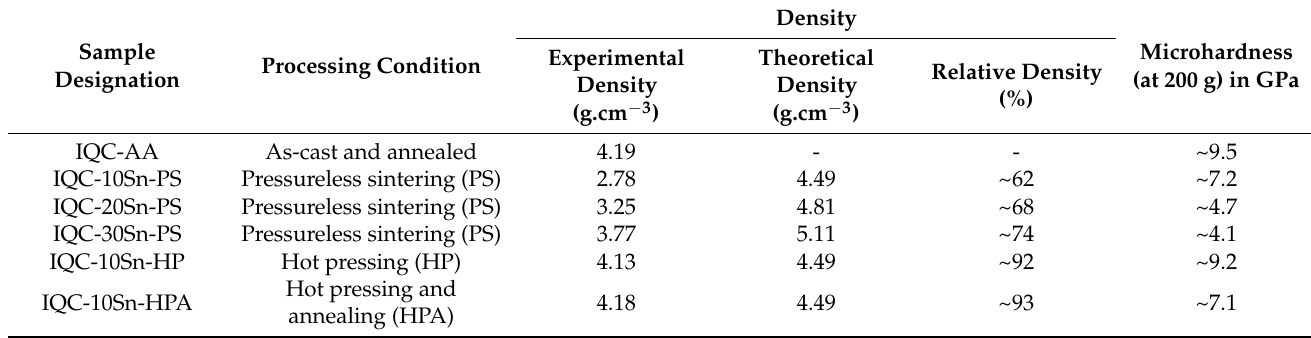
Table 2. Physical and mechanical properties of IQC-Sn-sintered composites.